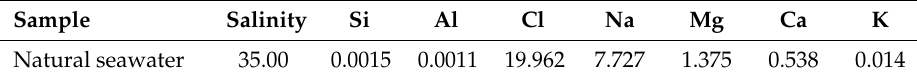
Table 2. Seawater composition (values in g / L; salinity g /